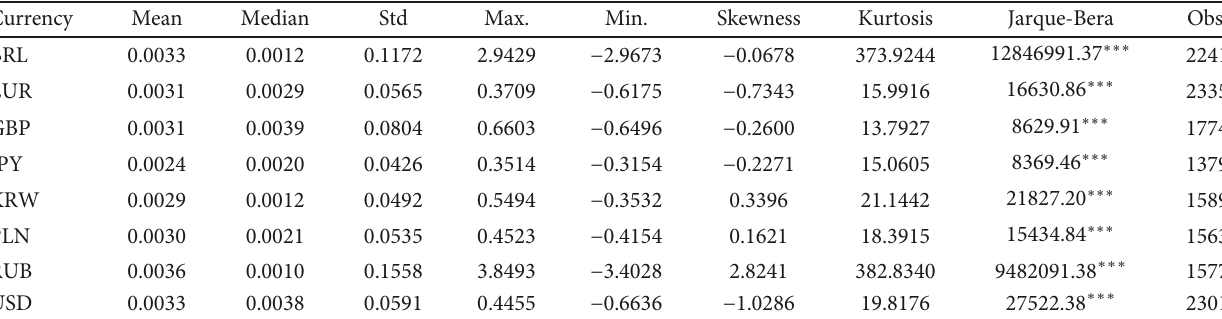
Table 4: Descriptive statistics for the Bitcoin market time